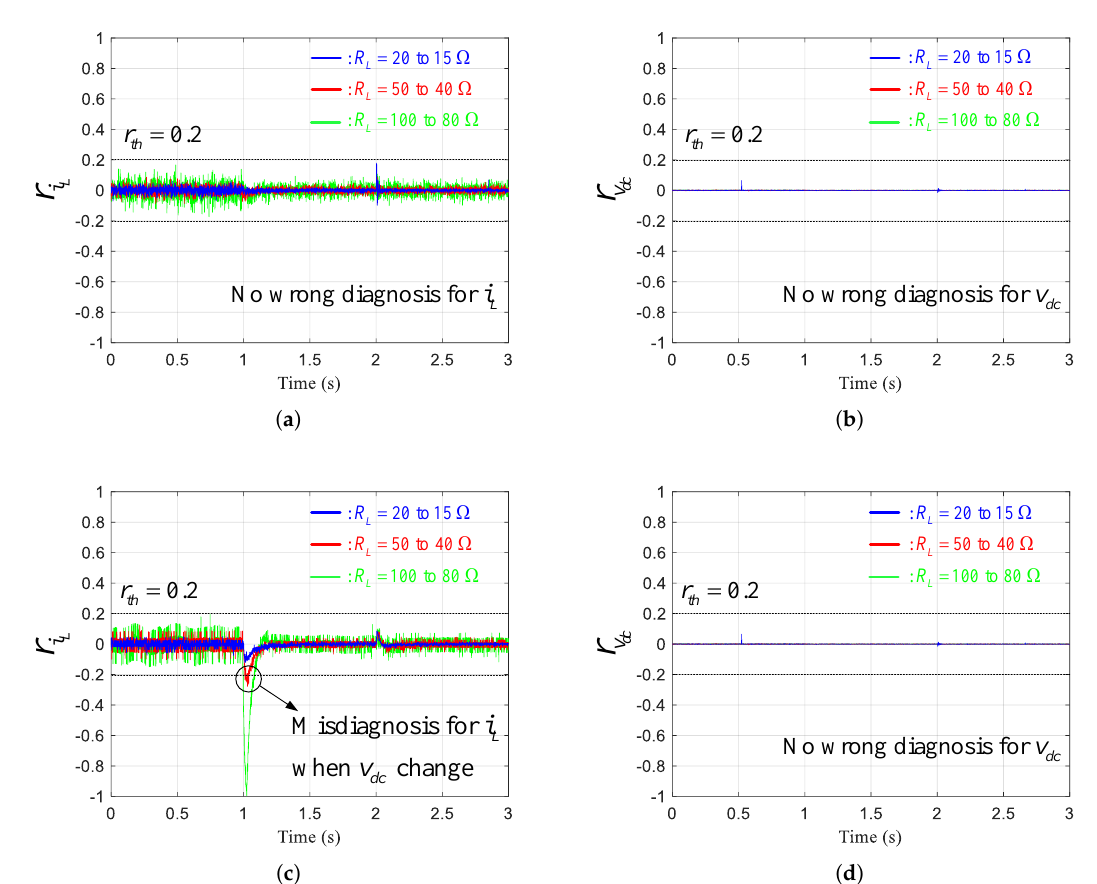
Figure 5. The normalized residuals of the proposed ( a , b ) and proportional-integral (PI) observers ( c , d ) under healthy